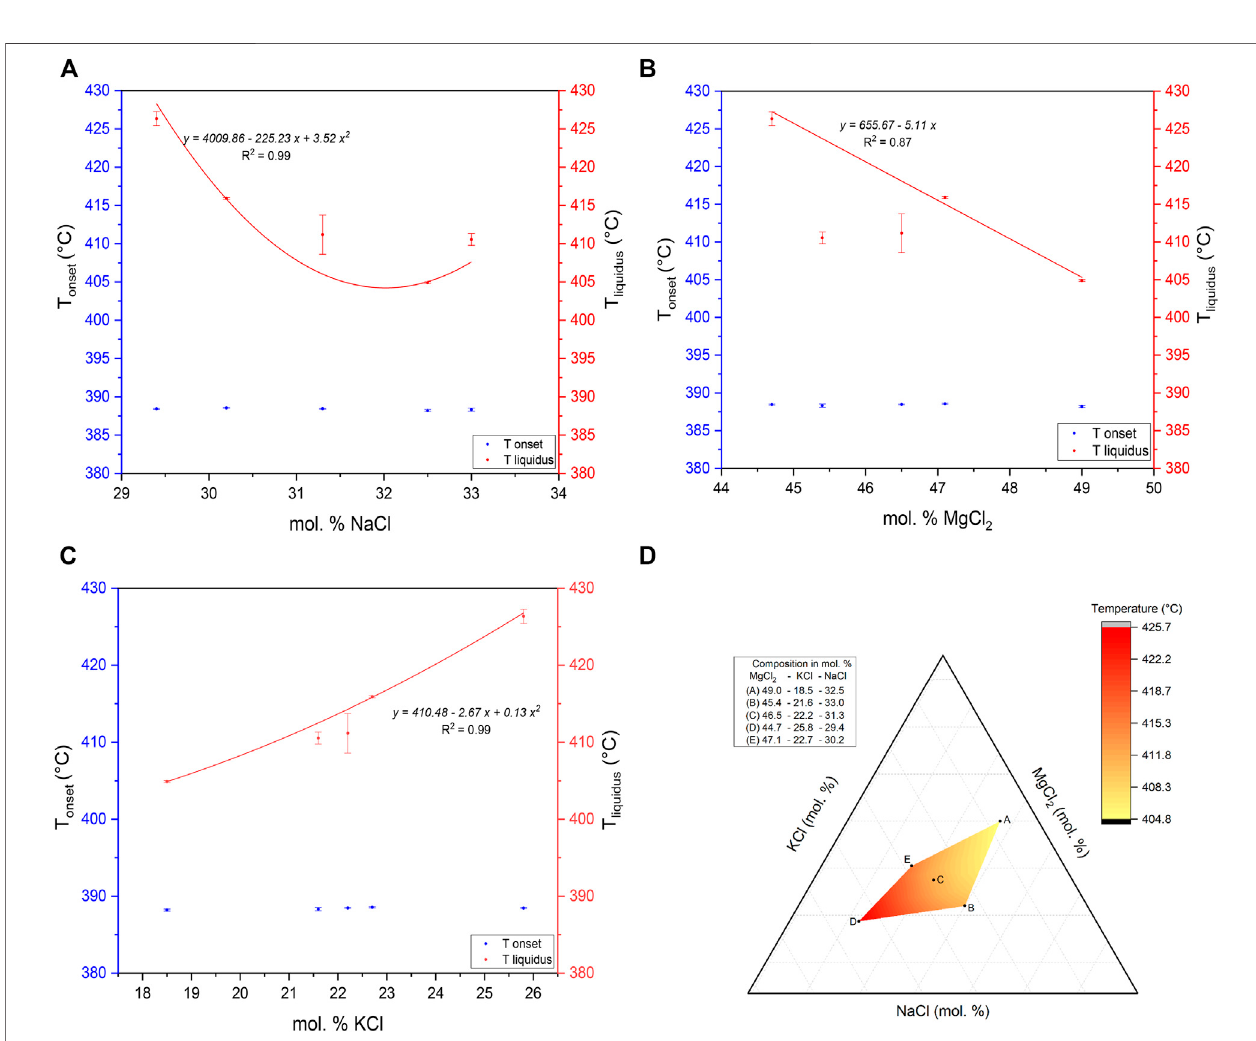
FIGURE 6 | Determined onset and liquidus at 10 K/min depending on (A) NaCl, (B) MgCl 2 , and (C) KCl concentration of DSC measurements for fi ve different ternary mixtures. (D) Detailed ampli fi ed triangle section.